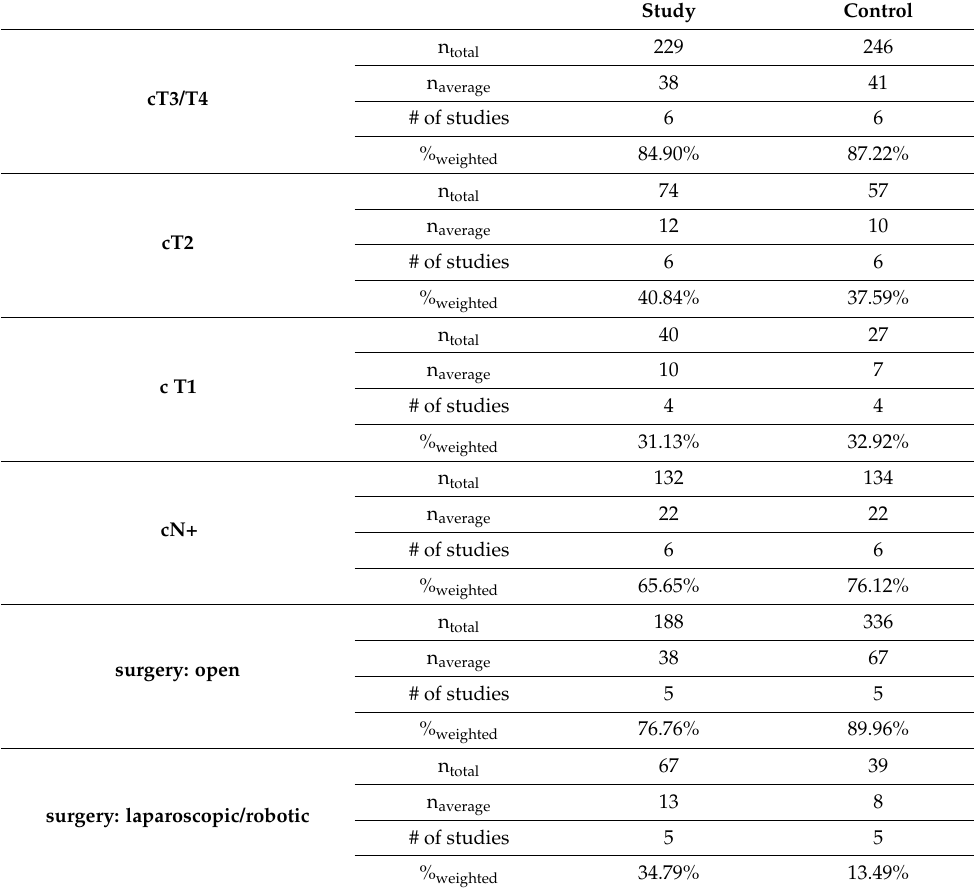
Table 2. Descriptive presentation of patient characteristics.